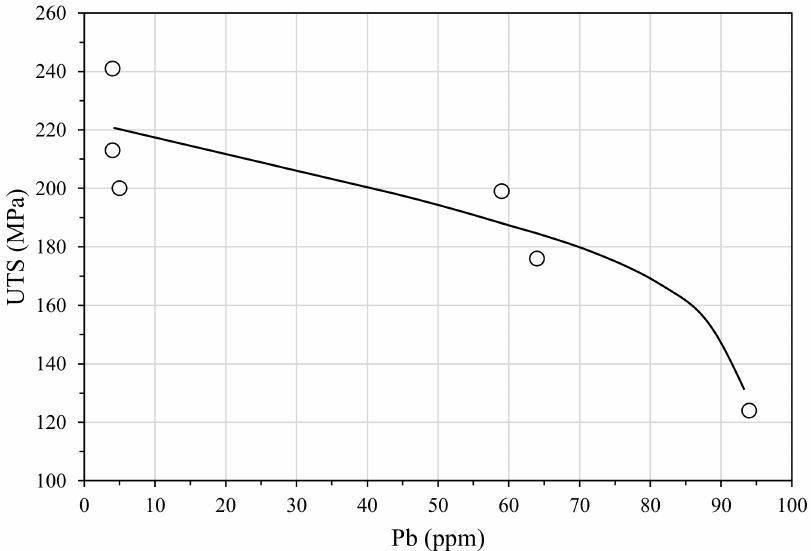
Figure 87. Evolution of ultimate tensile strength with lead content in grey cast irons